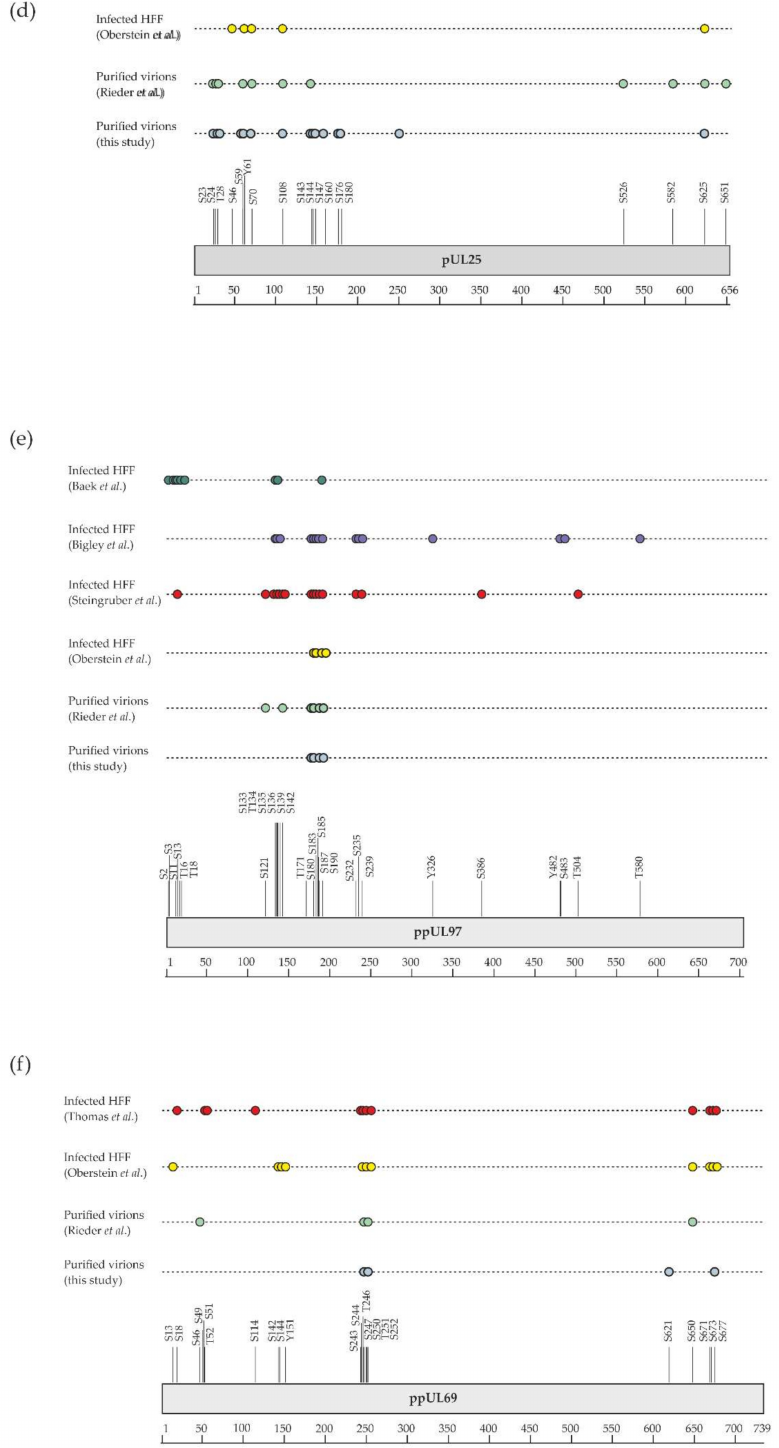
Figure 4. Graphical display of phosphosites identified in this study and by previous investigations (details are given in Supplementary Table S3). Shown are phosphosites found on ( a ) pUL32 / pp150, ( b ) pUL83 / pp65, ( c ) pUL82 / pp71, ( d ) pUL25, ( e ) pUL97, and ( f ) pUL69 in virions (this study and Rieder et al. [23]) and in infected cells [25,83–87] (HFF, human foreskin